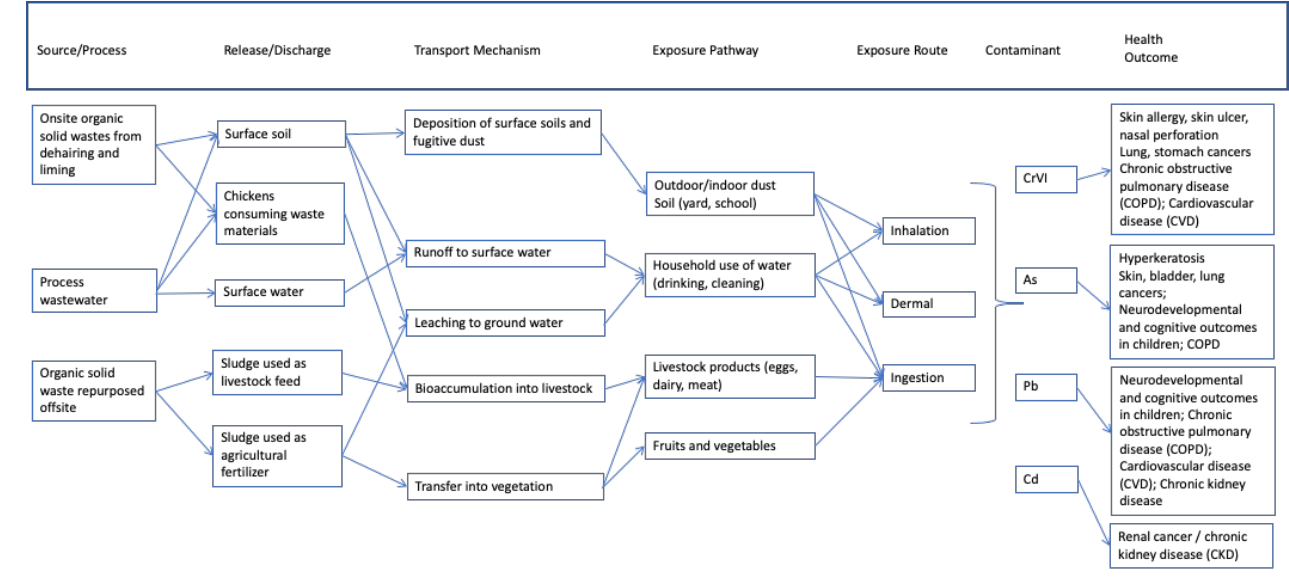
Figure 4. Generalized conceptual site model for small-scale leather processing and tanning activities. Table 1. Overview of sector-specific guiding